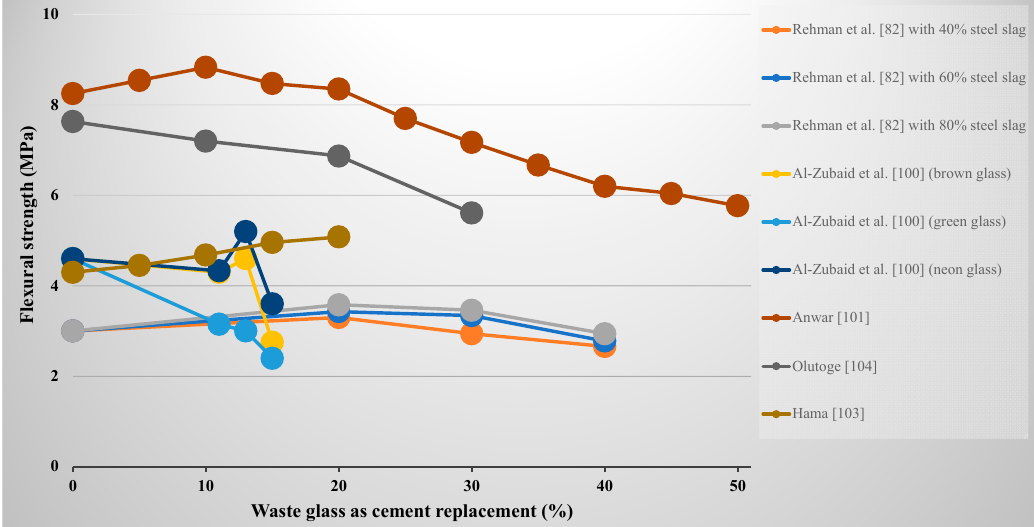
Figure 15. Effect of waste glass as cement replacement on 28-days flexural strength.